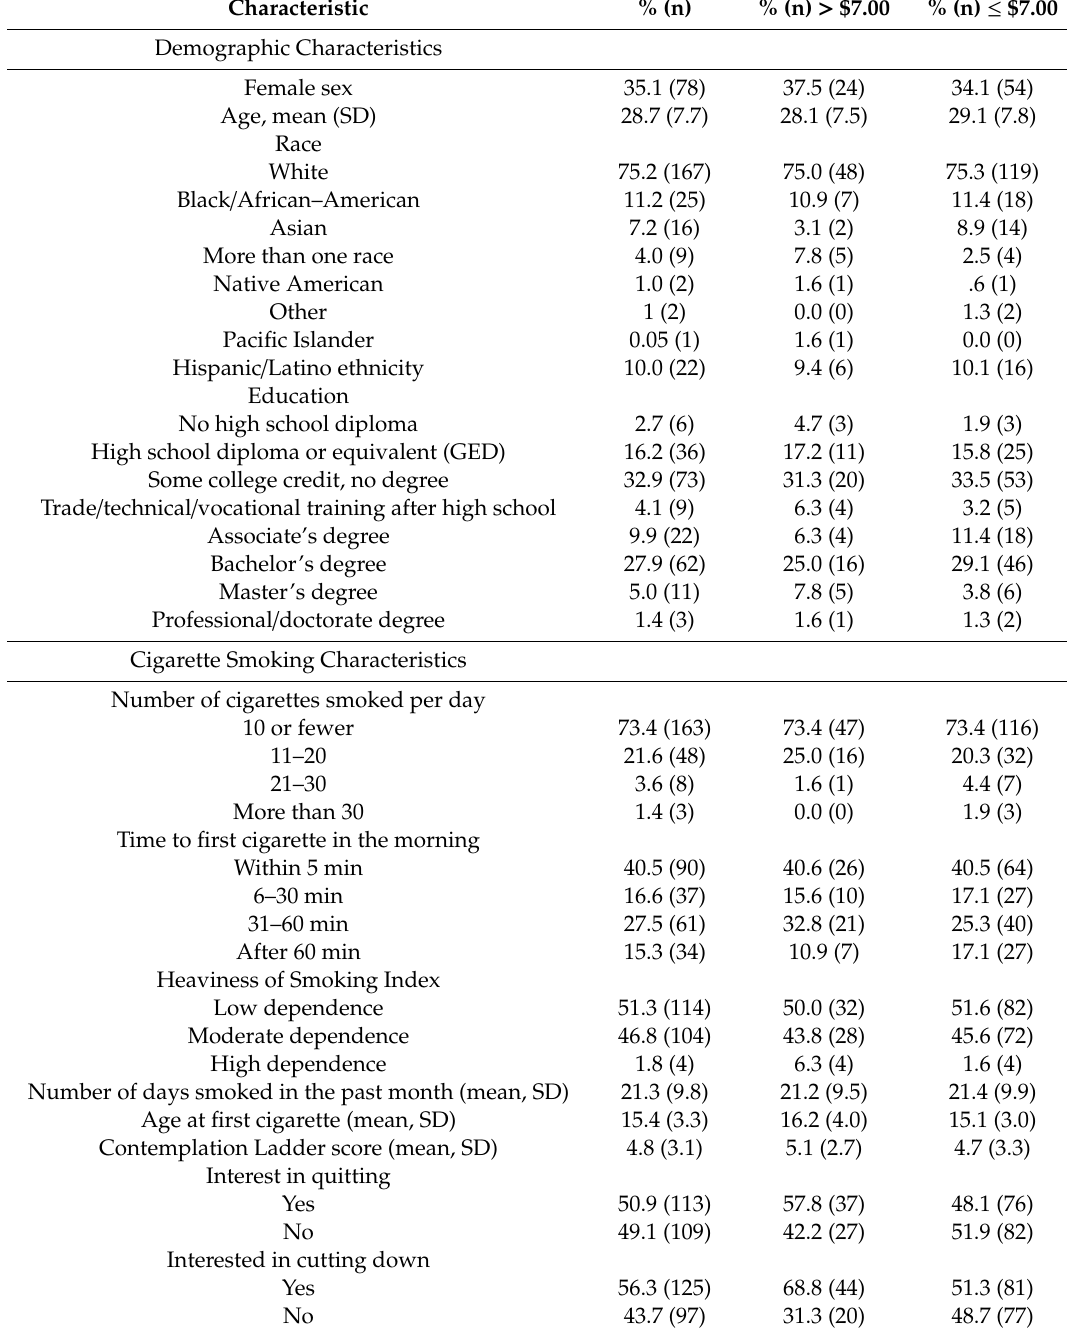
Table 1. Participant characteristics (n =